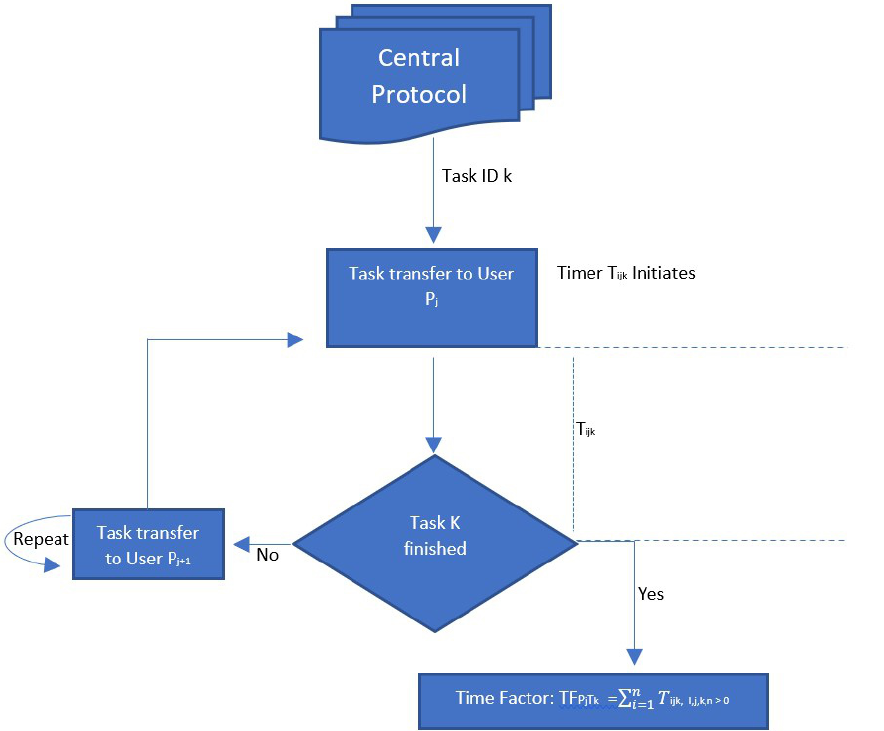
Figure 3. Measuring